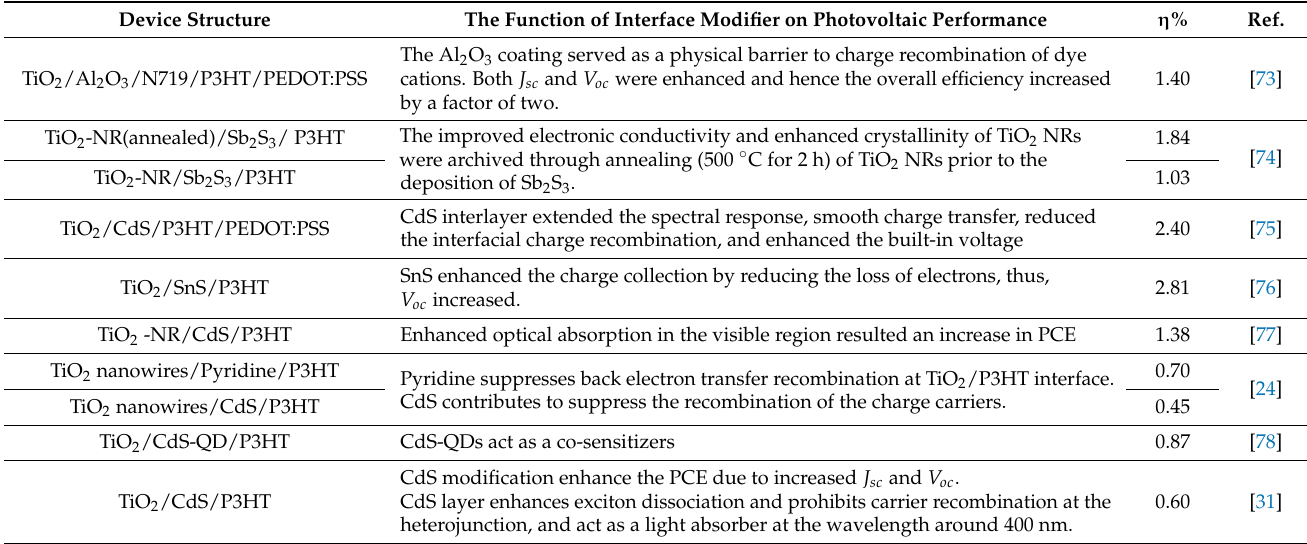
Table 2. Inorganic insulating/semiconducting layers as interfacial modifiers in hybrid Titanium dioxide/Poly(3-hexylthiophene) heterojunction solar